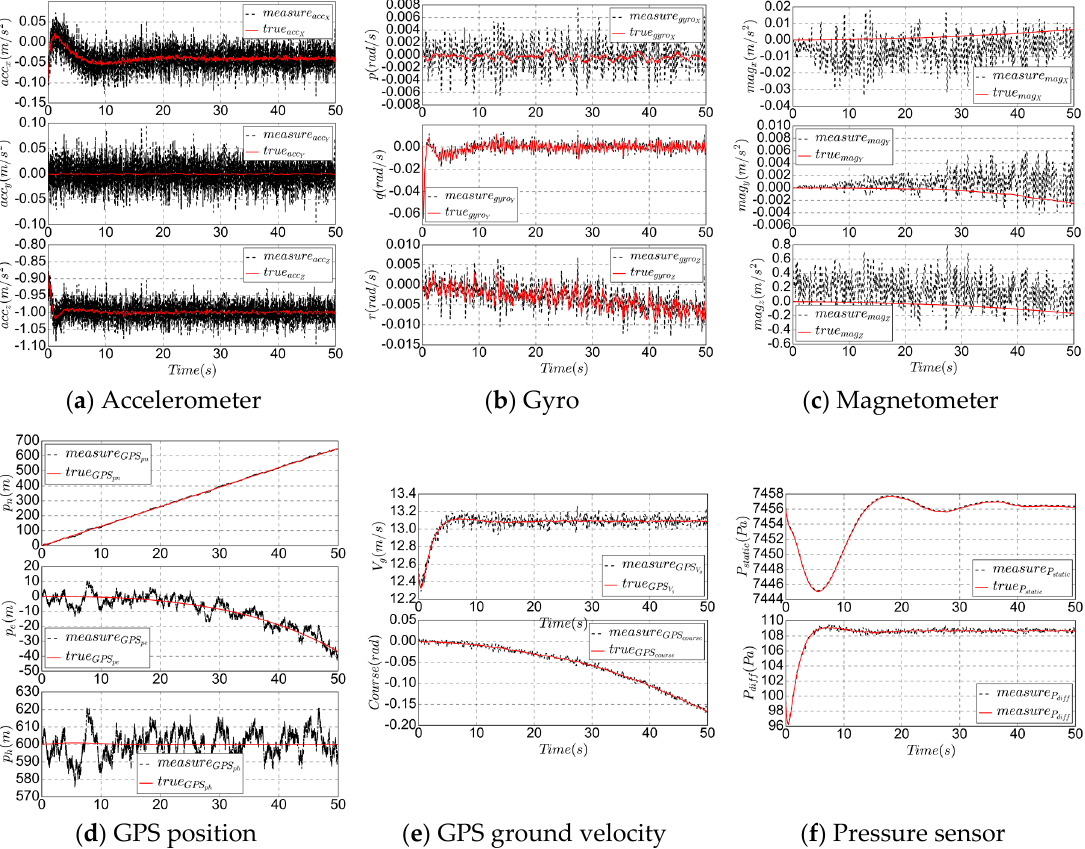
Figure 3. True states and measurement states of low ‐ cost sensors.